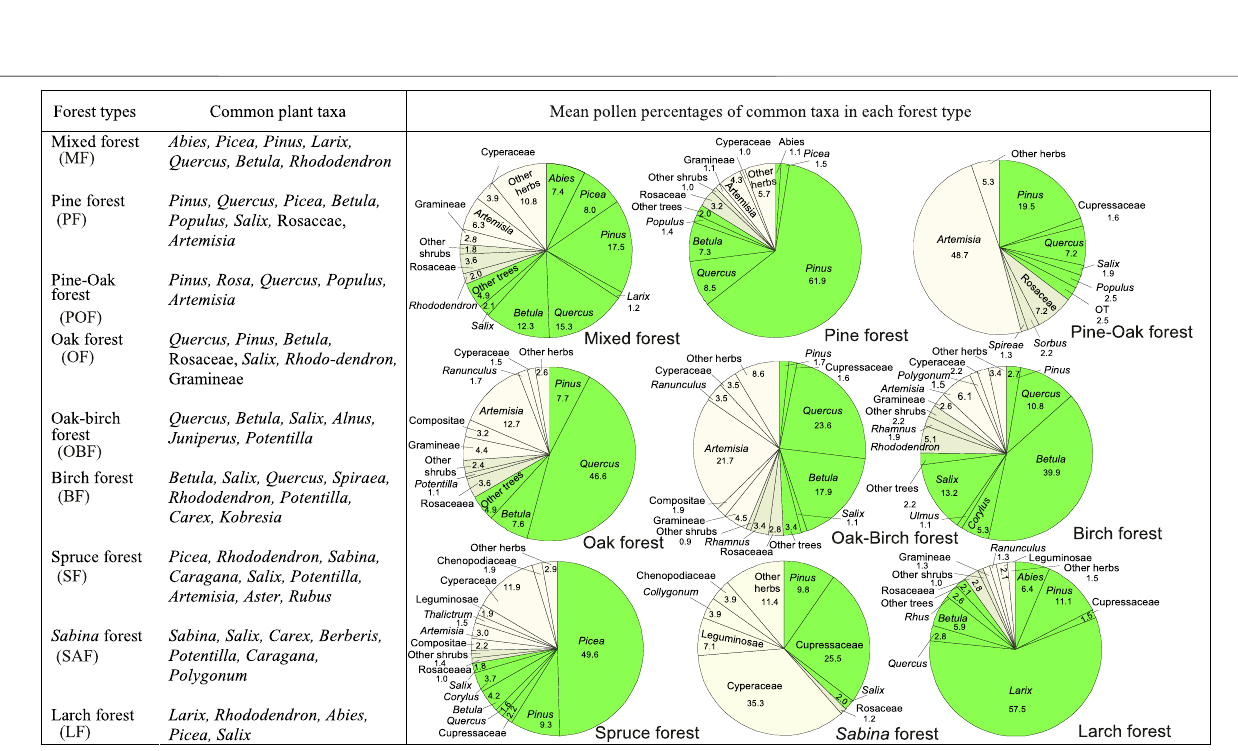
Frontiers in Earth Science |